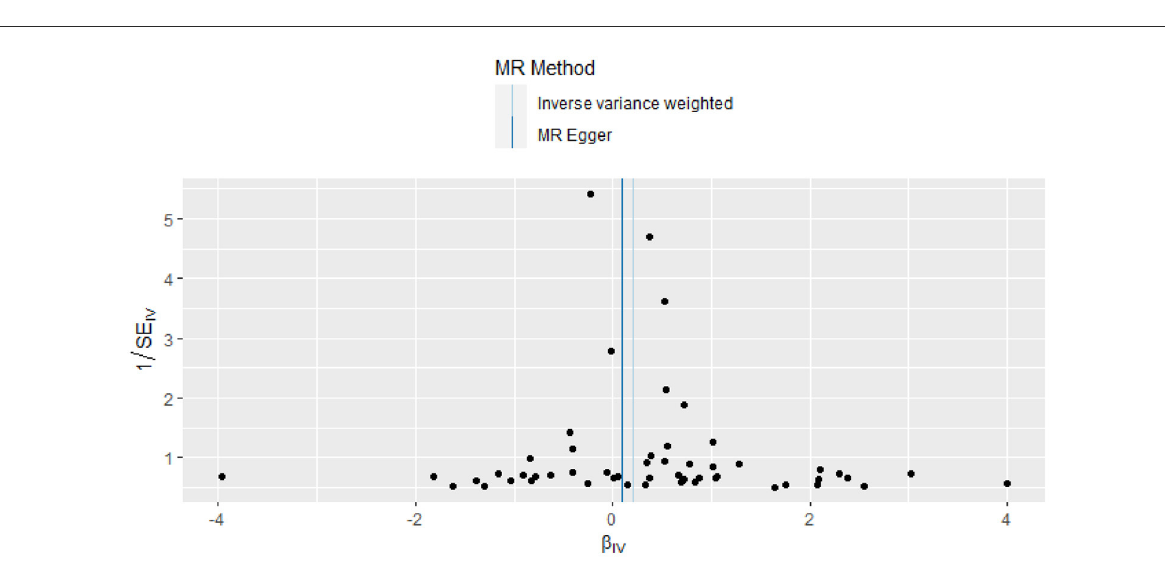
FIGURE3 Funnel plot of the causal effect of CRP related SNPs on